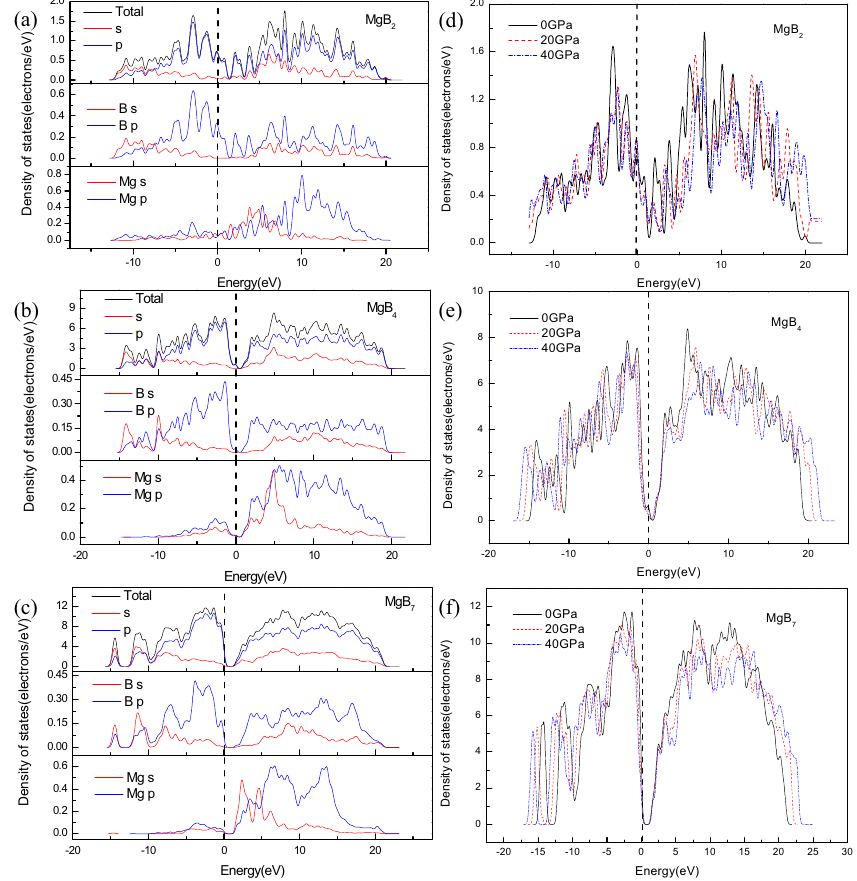
Figure 8. Density of states of Mg–B compounds, ( a , b , c ) are partial density of states for MgB 2 , MgB 4 , and MgB 7 , respectively; ( d , e , f ) are total density of states under various pressures for MgB 2 , MgB 4 , and MgB 7 , respectively.